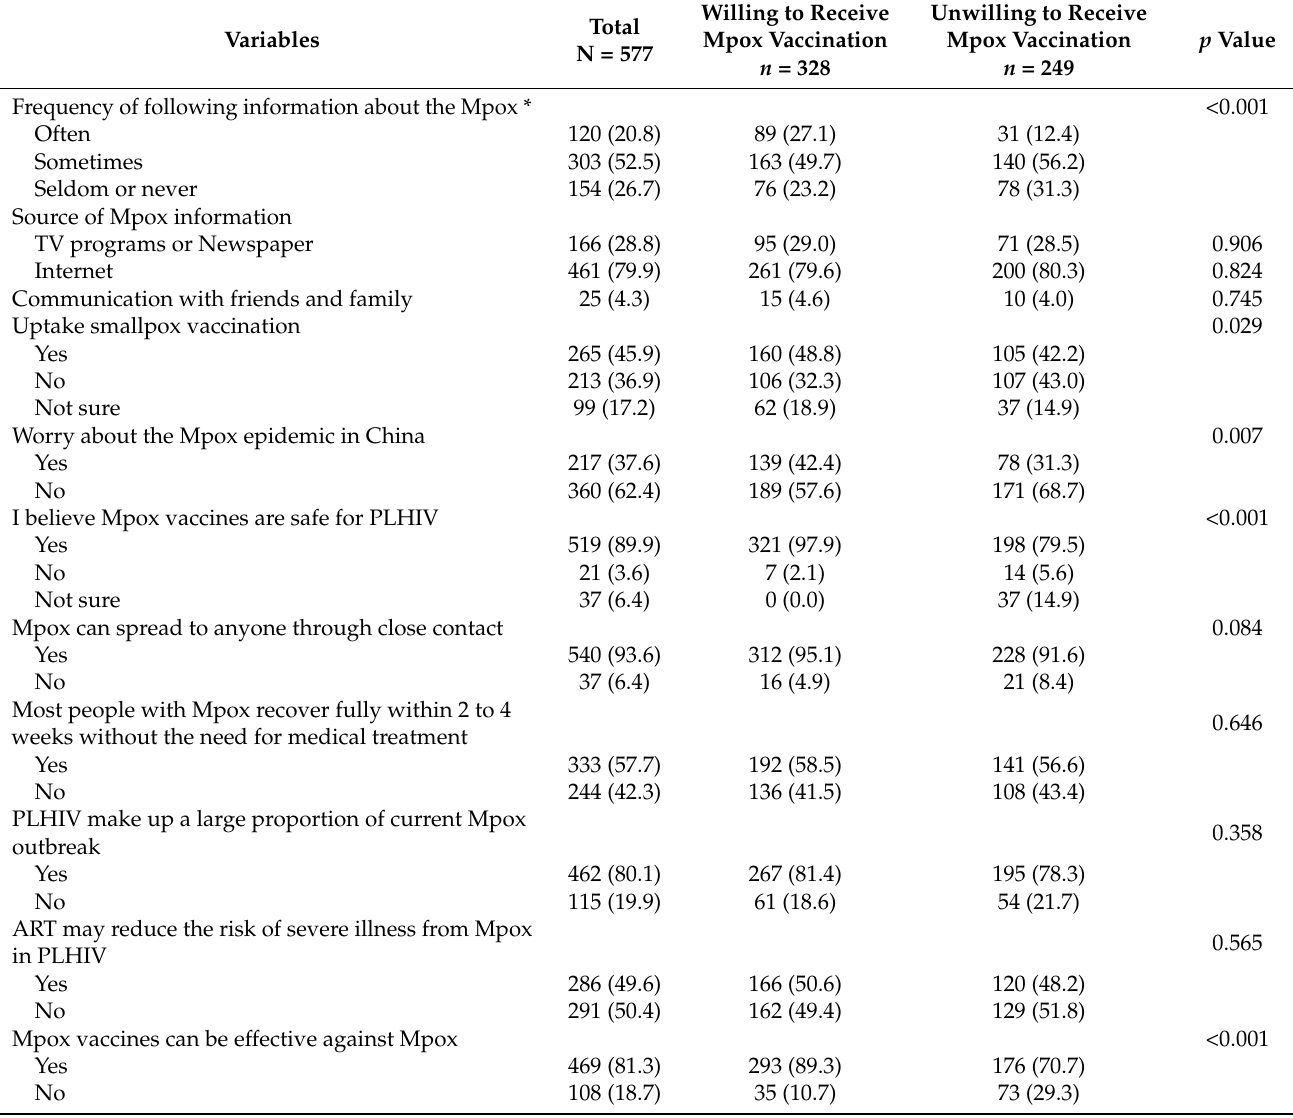
Table 3. Knowledge about Mpox variables related to willingness to get vaccinated among MSM living with HIV in